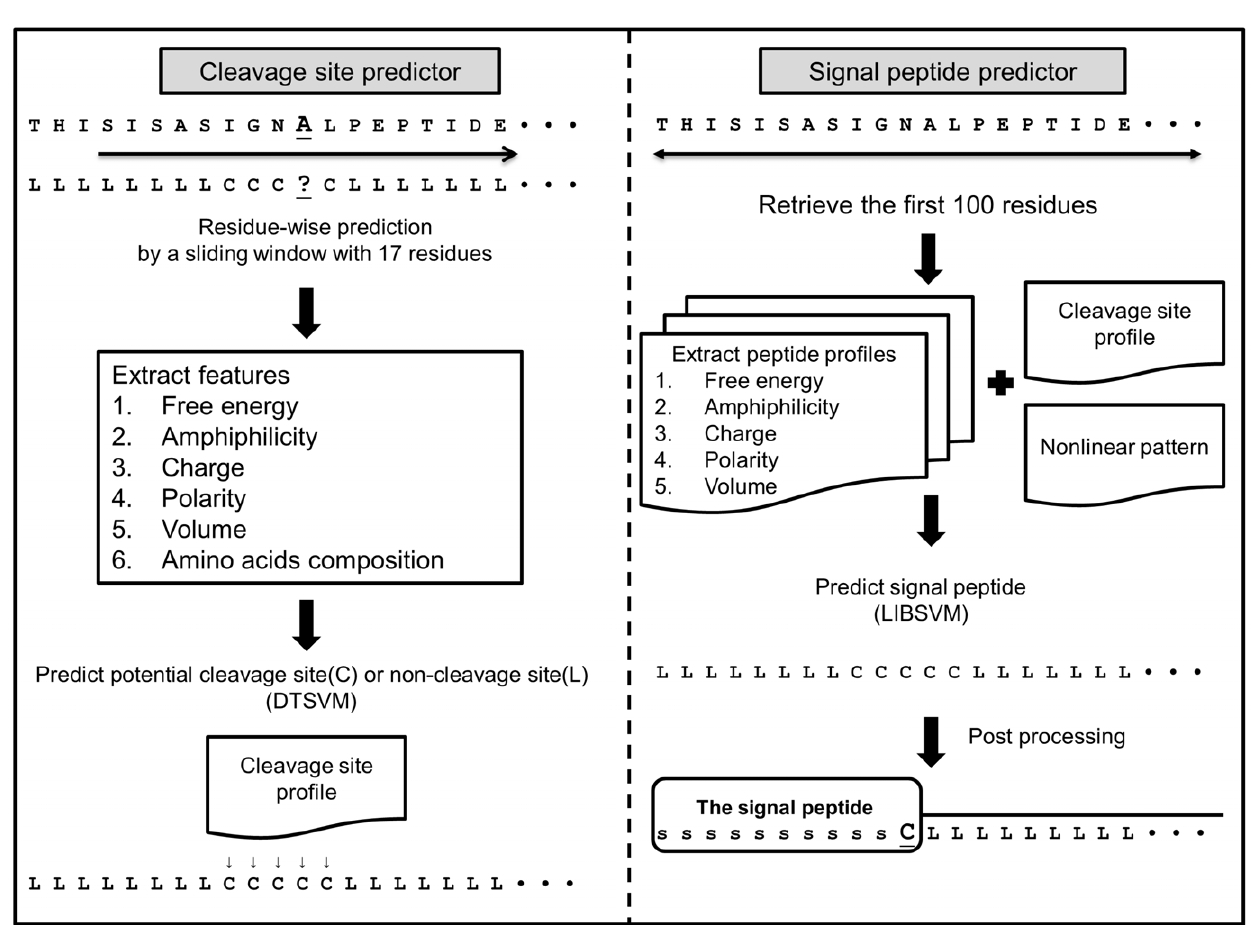
Figure 1. The hierarchical architecture of SVMSignal.